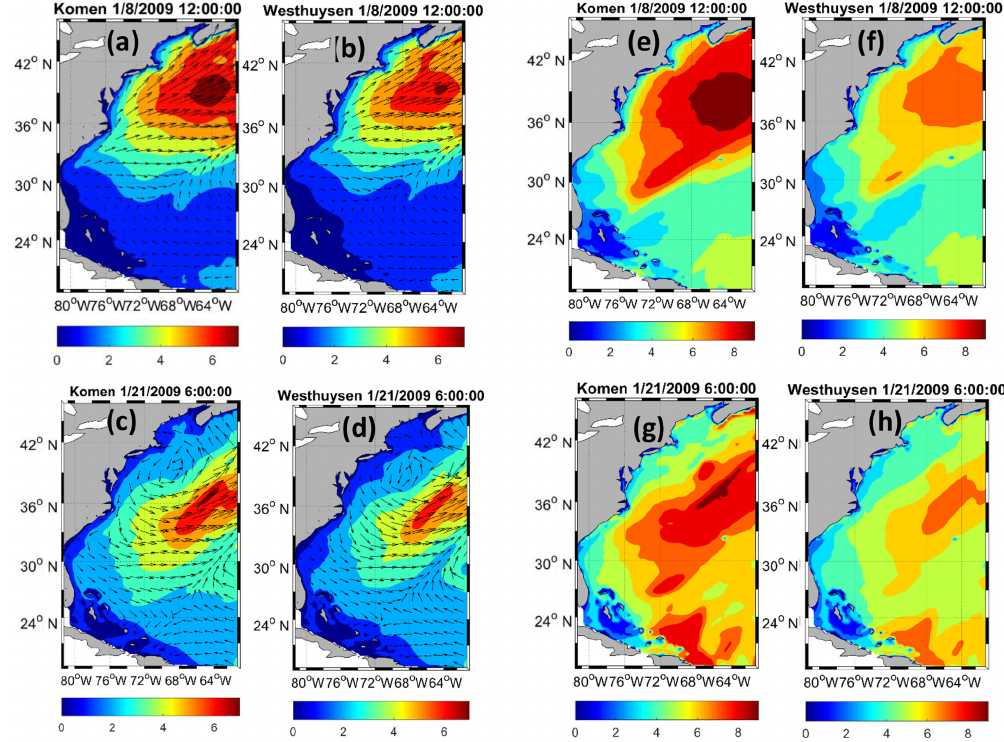
Figure 9. Simulated wave height ( H m0 ) and direction over the modeling area using Komen and Westhuysen whitecapping formulas for times t1 (a, b) and t2 (c, d) and simulation results for mean wave periods ( T m02 ) for times t1 (e, f) and t2 (g, h) .